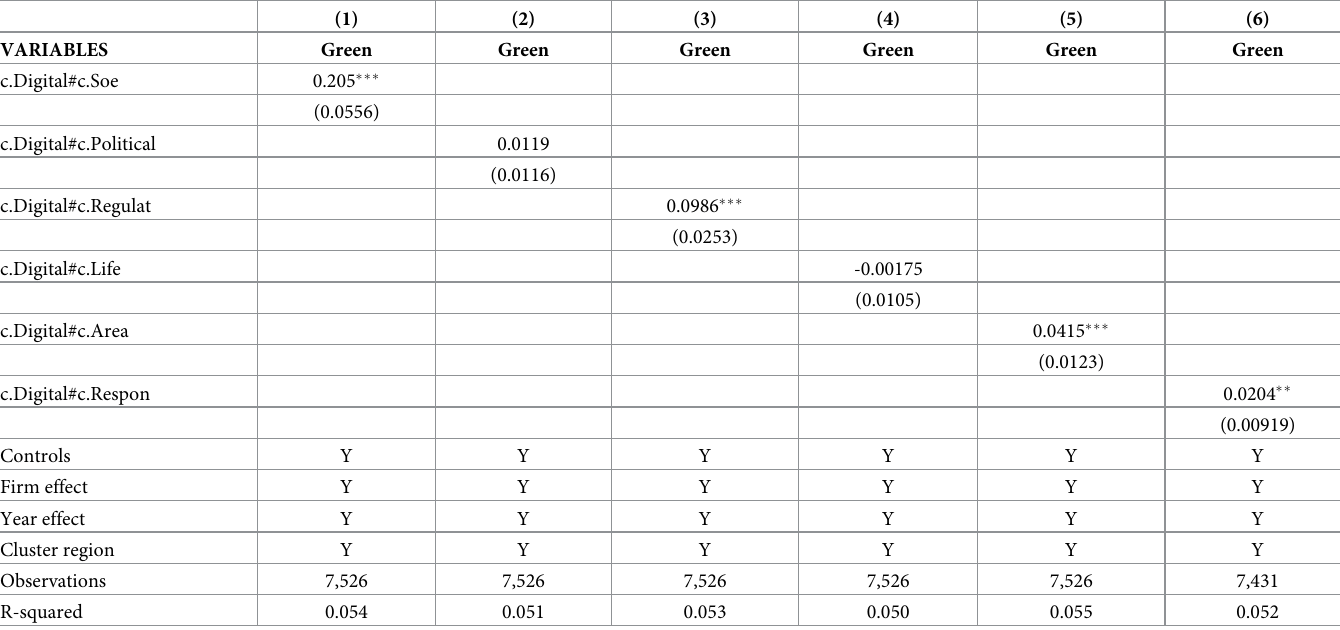
Table 10. Heterogeneity